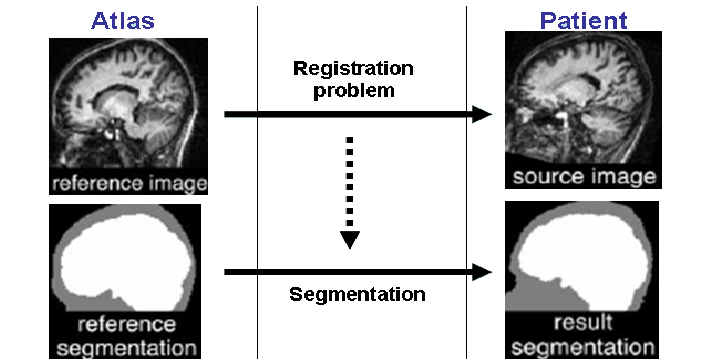
Figure 1. Atlas-based segmentation